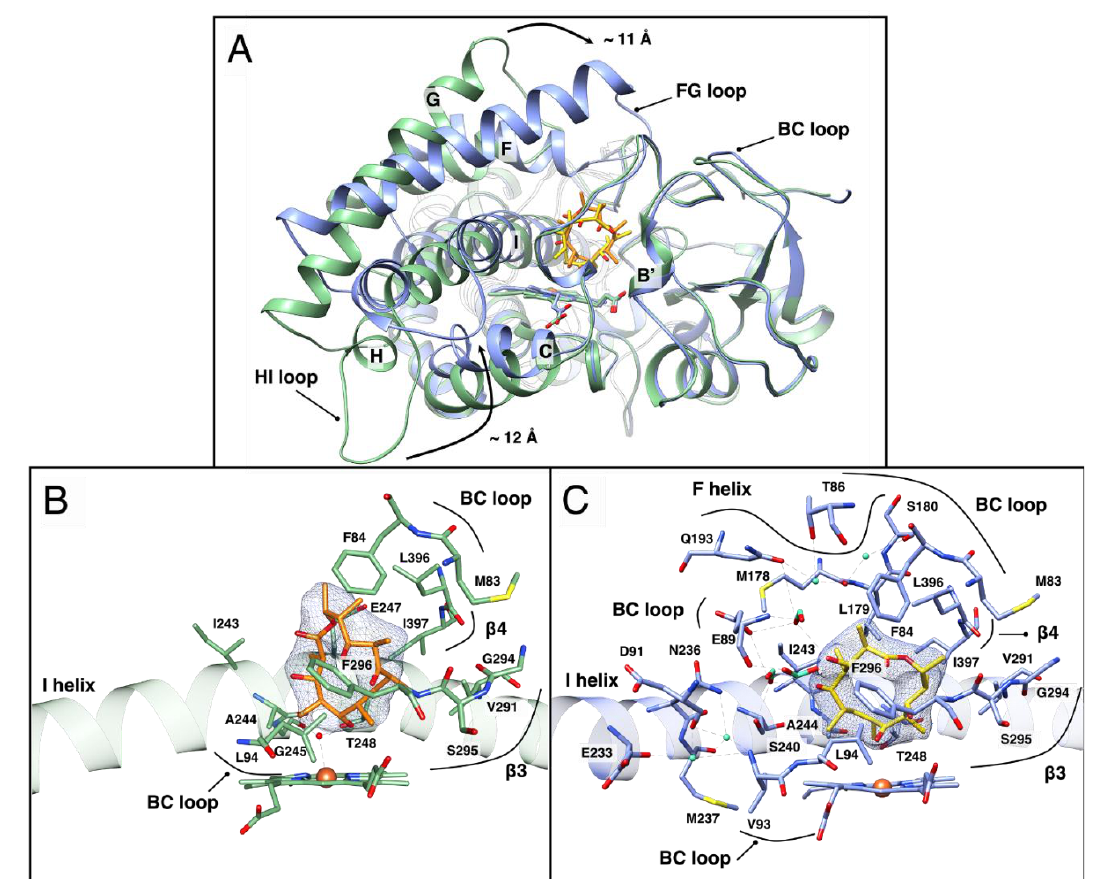
Figure 3. OleP – DEO structure. ( A ). Secondary structure superposition of the open (green) and closed (blue) conformations of OleP – DEO complex. The structures are displayed in a nonstandard orientation for P450s to enable the visualization of the structural transition. DEO molecules in the open and in the closed states are in orange and in yellow sticks, respectively. ( B , C ) Close up views of the active site of open ( B , green) and closed ( C , blue) OleP in complex with DEO. Red sphere: sixth coordinating water molecule; dashed lines: hydrogen bonds. In panel C, water and formate ions that mediate interactions between protein and substrate are represented as aquamarine spheres and sticks, respectively. Secondary structural elements and amino acids involved in OleP – DEO interactions are labeled. In both panels, the electron density map (2F o – F c ) contoured at 1 σ around DEO is shown as a blue mesh.